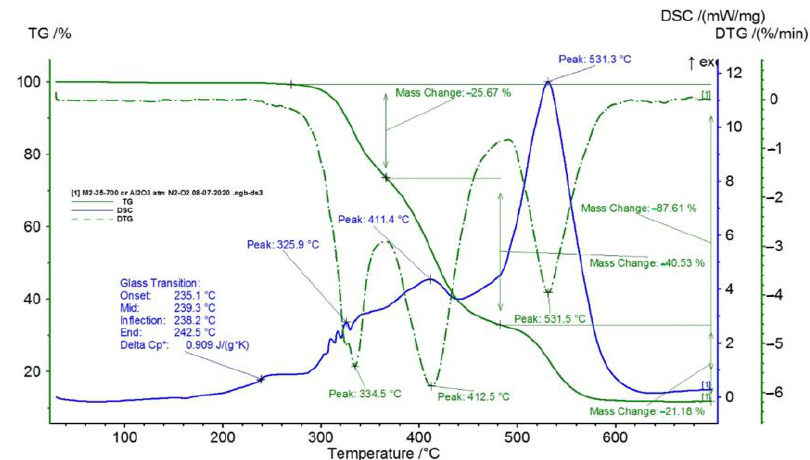
Figure 6. TG/DSC variation for sample M2.